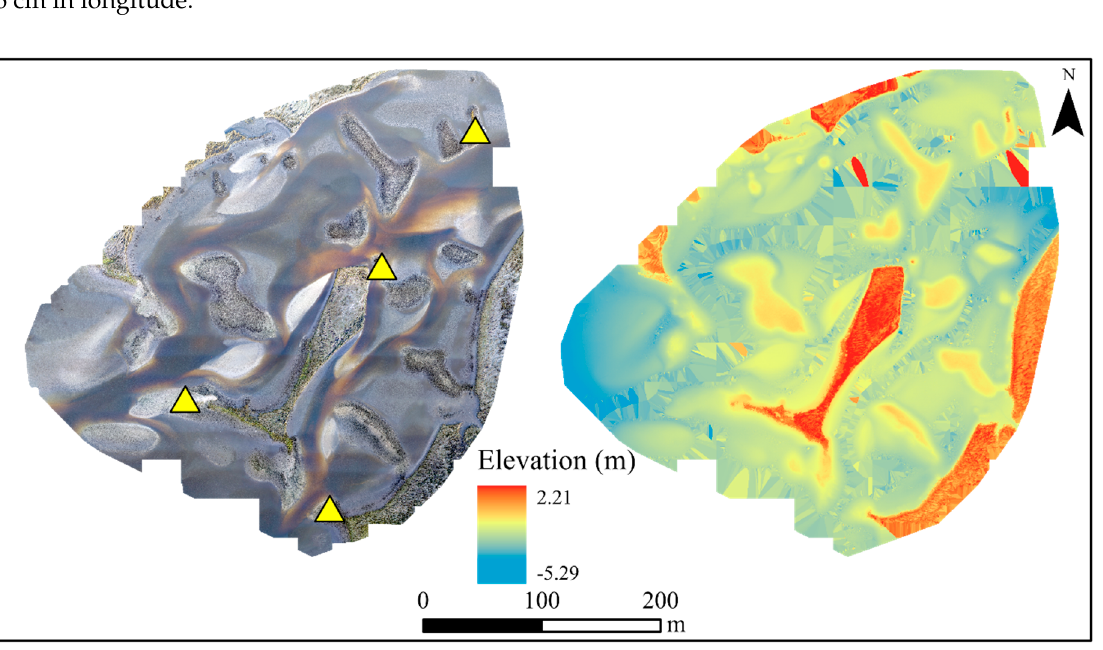
Figure 5. Orthomosaic ( left ) and digital surface model ( right ) developed from the collected imagery. The yellow triangles on the orthomosaic represent the placement of ground targets. Difficulties with finding image matching points resulted in some artifacts over water in the digital surface model because of the extensive interpolation.